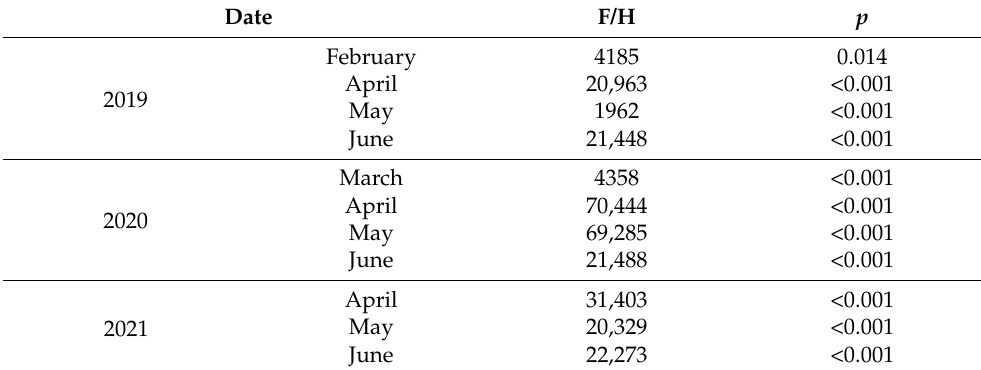
Table 3. Significance of the one-way ANOVA or Kruskal–Wallis test. F/H and p values of each sampling